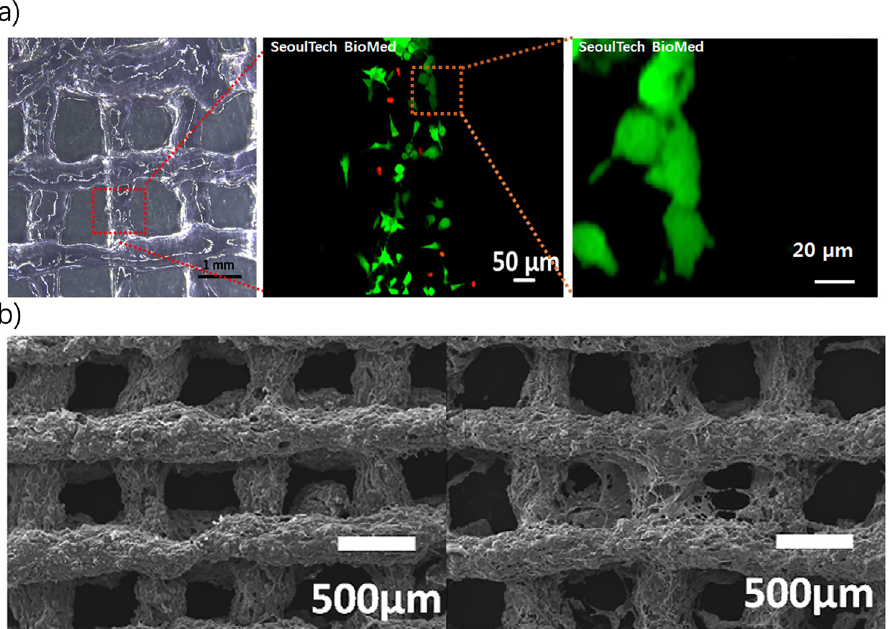
Figure 7: ( a ) Live and dead assay results of hybrid hydrogel by HA, HEA, and gelatin - methacryloyl [ 109 ] . ( b ) A bioink consisting of HA, silk fi broin, gelatin, and tricalcium phosphate treated with/without the platelet - rich plasma [ 110 ] . The HA - based bioinks showed excellent biocompatibility and good